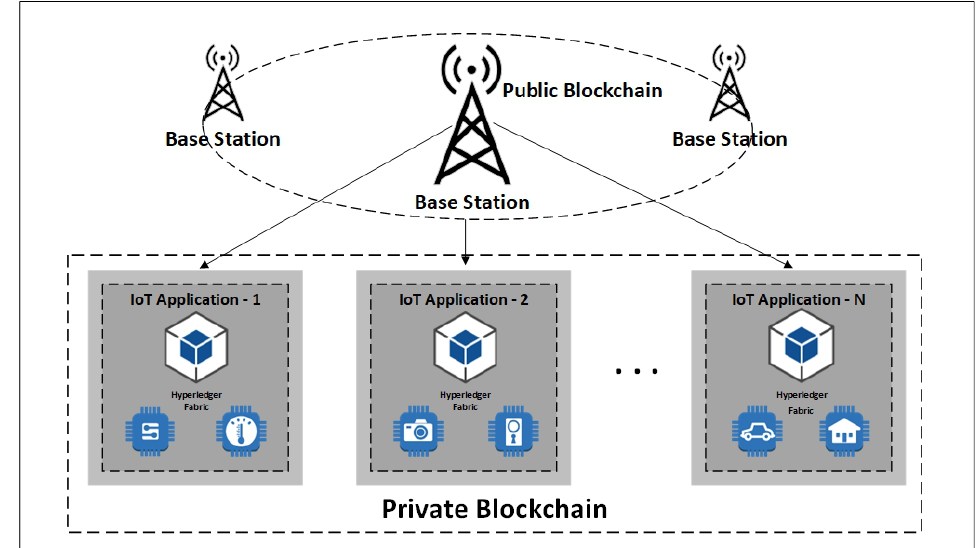
Figure 4. Blockchain-based edge